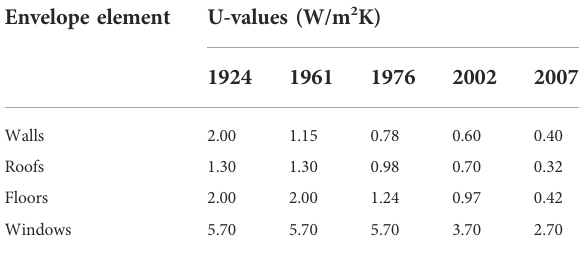
TABLE 2 U-values (W/m2K) in the Italian building regulation (Corrado et al., 2011; Bournas, 2018). Envelope